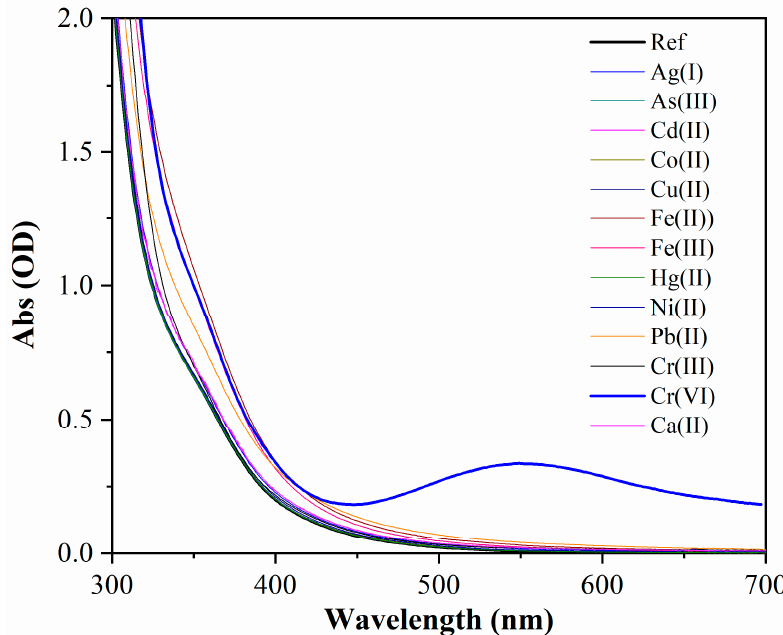
Figure 6. Selective response of UV-vis absorption spectra of N-CDs-W-THF upon the addition of different HM ions at a concentration of 100 µM and calcium ions at 1 mM. Note that As(III) is present as the anion AsO 33 − in water, which is in contrast to all the other metals, which are present as